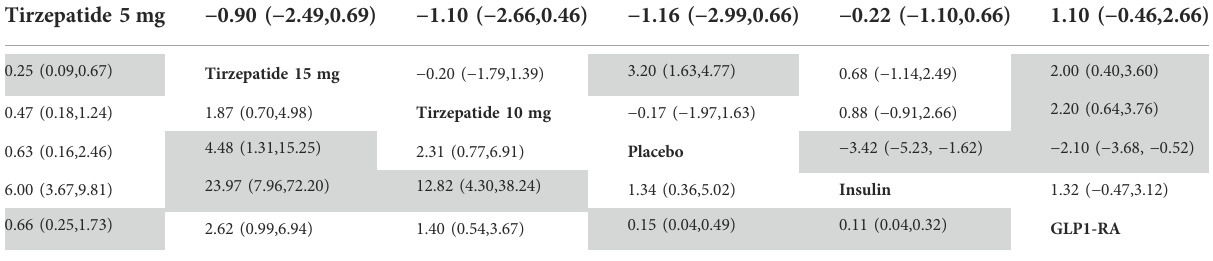
TABLE 3 Results of the network meta-analysis of the FSG (upper right quarter) and gastrointestinal adverse events (lower left quarter).